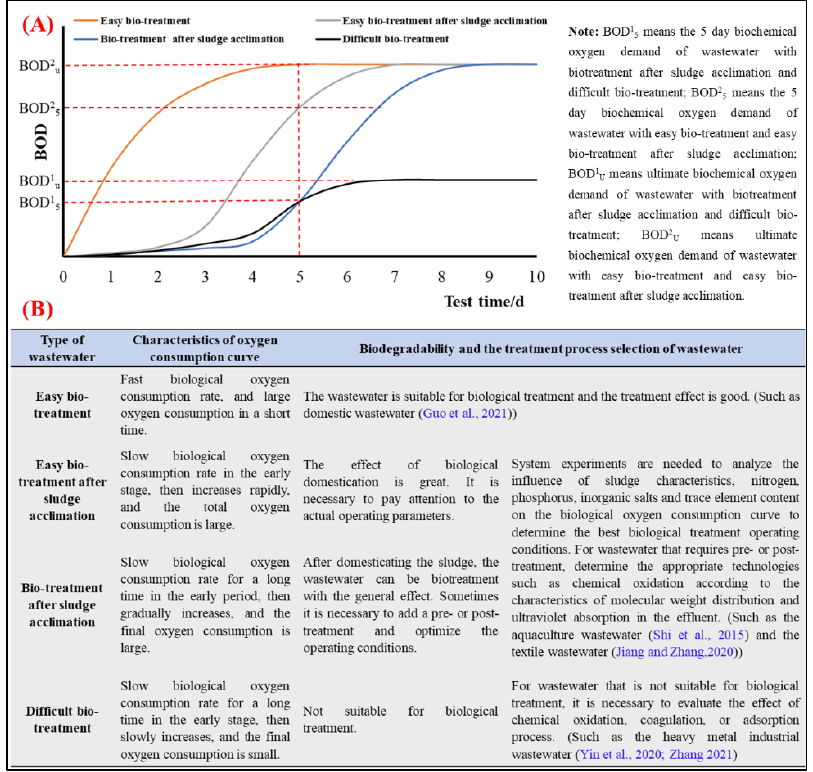
Figure 1. Curve diagram of four categories wastewater; ( A ) Oxygen consumption process; ( B ) Classification of biodegradability and current treatment situation.